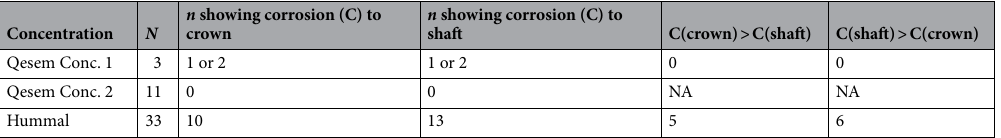
Table 3. Summary of corrosion damage to teeth of pleurodont lizards from Qesem Cave, Israel, and Hummal, Syria. Concentration numbers for Qesem Cave follow Smith et al. 64 . Four specimens of Pseudopus sp. from Concentration 2 were excluded (see